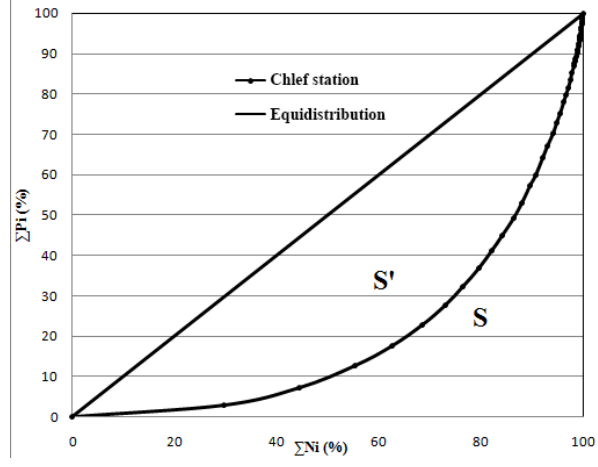
Figure 3. Concentration curve adjusted from the exponential curve of the Chlef meteorological station